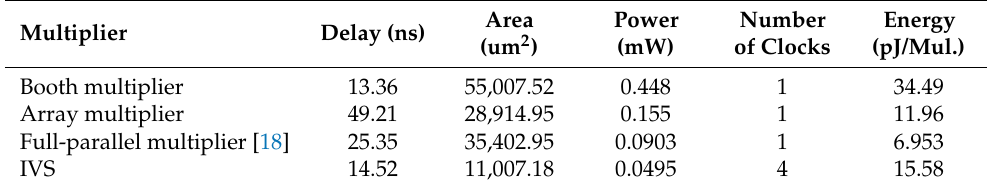
Table 4. Comparison of 64-bit multipliers with different architectures (clock frequency = 13 MHz).